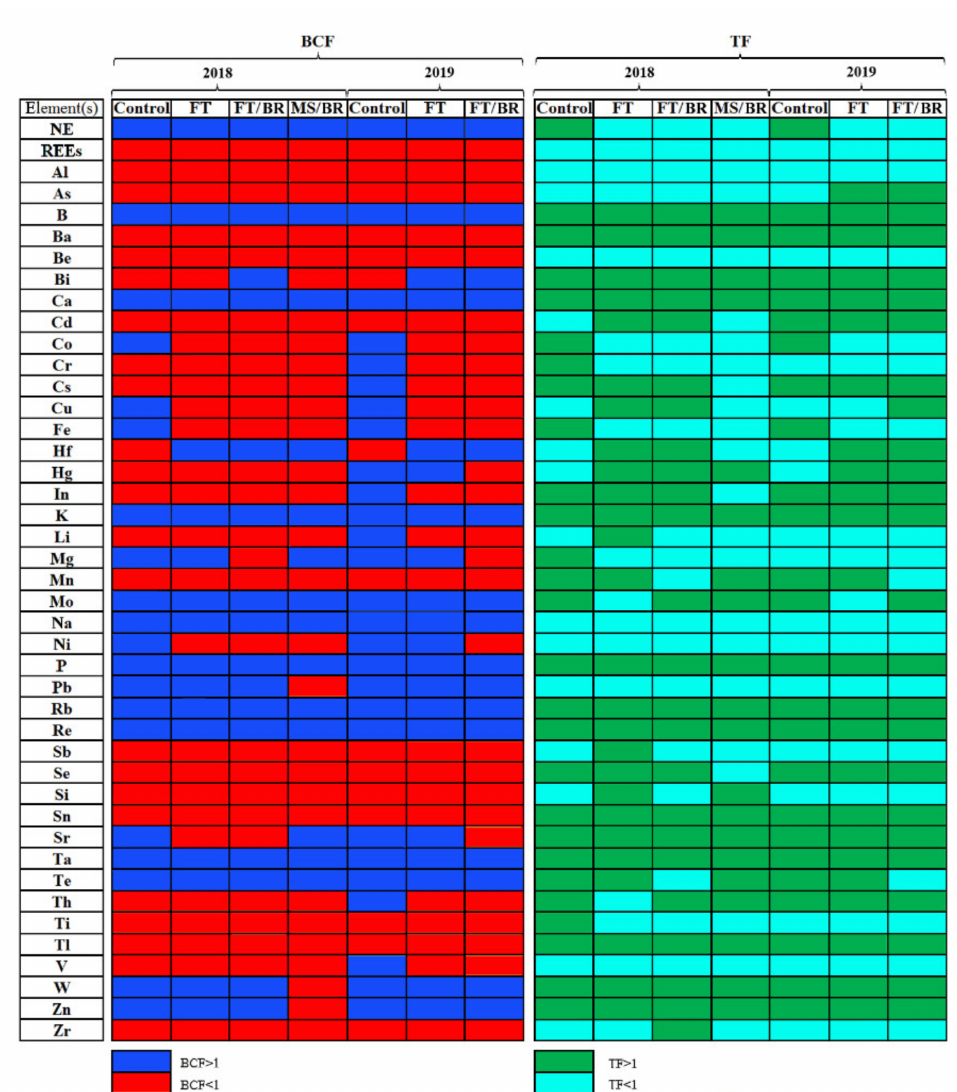
Figure 4. Bioconcentration factor (BCF) and translocation factor (TF) values calculated for determined elements in Paulownia cultivated in particular experimental